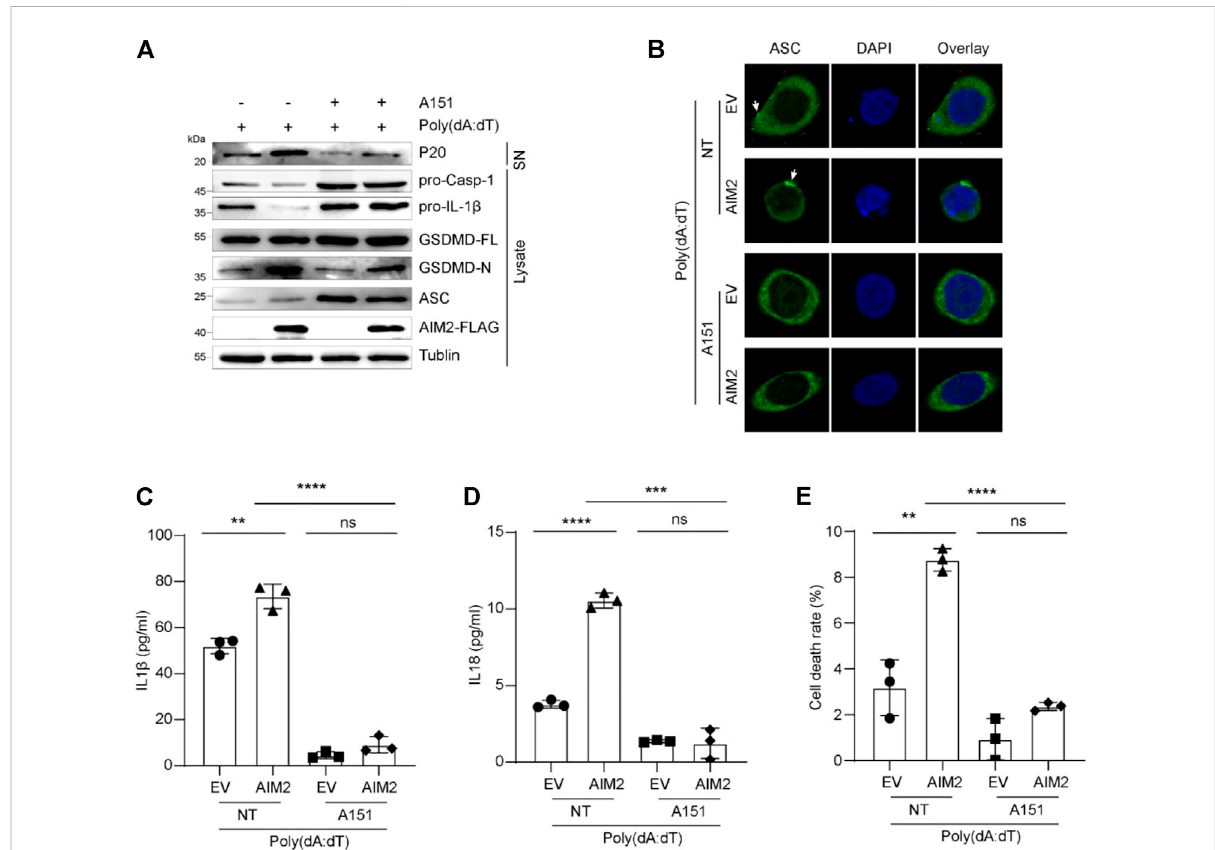
FIGURE 4 A151 inhibits the activation of AIM2 in fl ammasome in vitro . (A) Immunoblot analysis of p20 in the supernatants, and pro-caspase-1, pro-IL-1 β , and GSDMD in the lysates of 5637 cells. (B) IF images of AIM2-overexpressed 5637 cells and the control with or without A151 inhibition before being transfected with poly (dA:dT). White arrows indicate the ASC specks. (C) ELISA of IL-1 β in the supernatants of 5637 cells with or without A151 inhibition. (D) ELISA of IL-18 in the supernatants of 5637 cells with or without A151 inhibition. (E) LDH release in the supernatants of A151 treated 5637 cells and the control. The cells were pre-treated with A151 (1 μ M, 1 h) or not followed by poly (dA:dT) (1 μ g/ml, 9 h). Data in (C – E) are presented as the means ± SEM. p -values in (C – E) were calculated using the student ’ s t -test. * indicates p < 0.05, **, p < 0.01, ***, p < 0.001, ****, p < 0.0001; ns, not signi fi cant ( p >